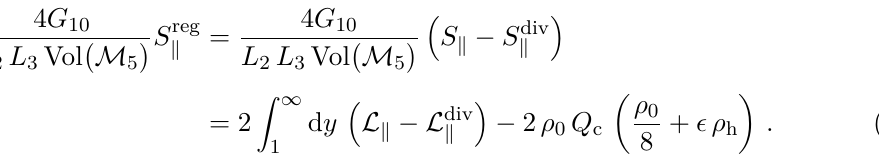
, and increases it for big ˜ l . The k k